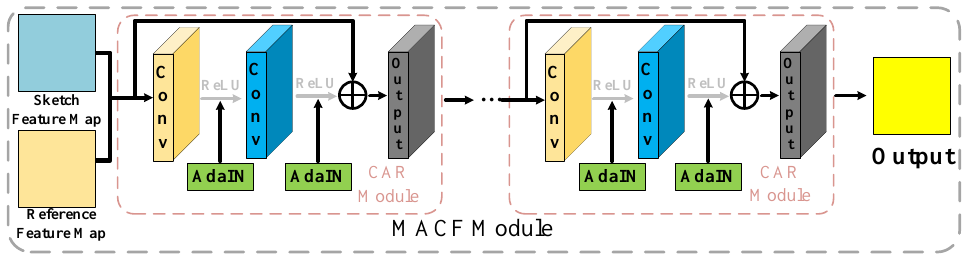
Figure 3. The proposed multi-level adaptive-instance-normalized color fusion (MACF) consists of four identical CAR modules. Given a set of sketch and reference images, different results are output by level-by-level CAR. It is a multi-level operation that enables the natural fusion of color features with sketch